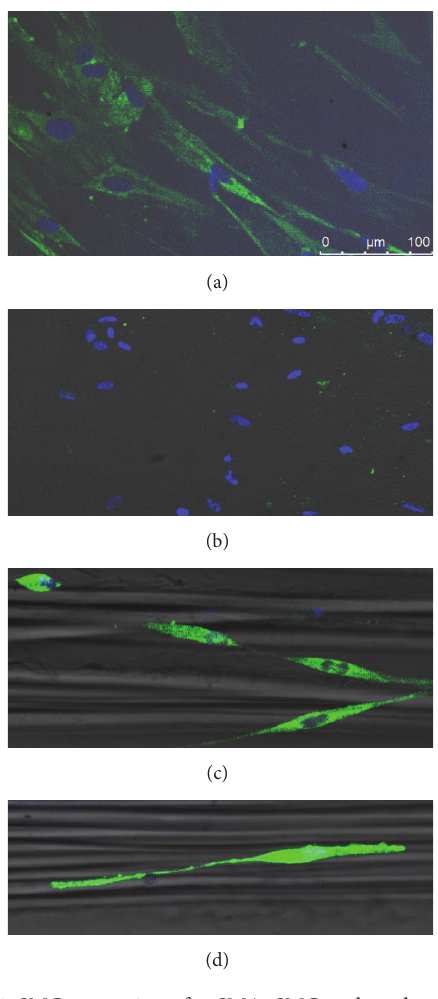
Figure 4: SMC expression of 𝛼 -SMA. SMCs cultured on chitosan films for 3 days (a) and 7 days (b), SMCs on aligned chitosan coated PCL after 3 days (c) and 7 days (d). All cells stained for 𝛼 -SMA and with DAPI nuclear stain.